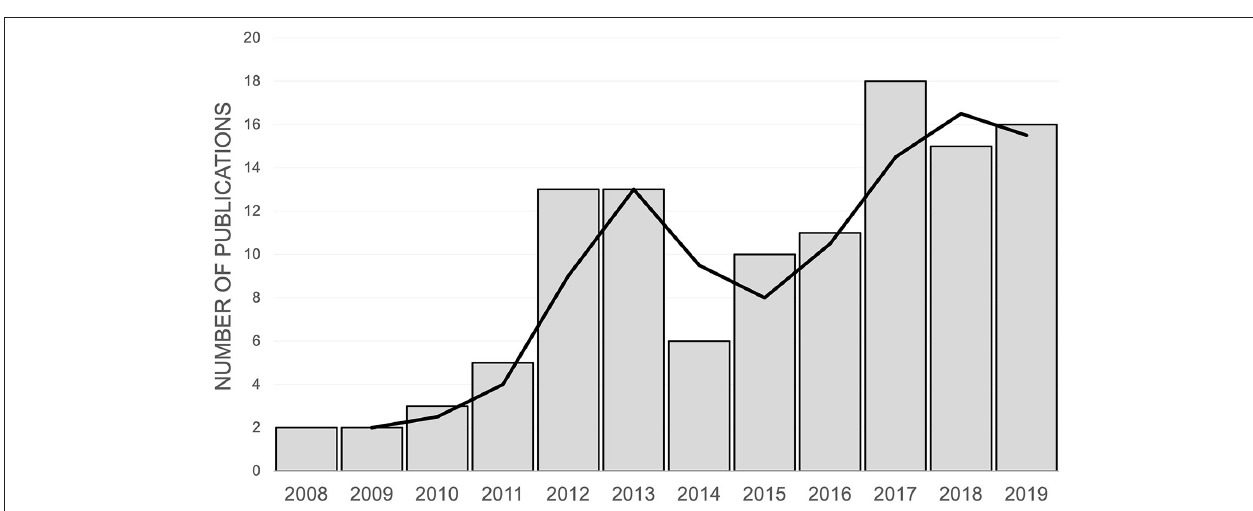
FIGURE 2 | The number of publications using the CMPS-SF by year of publication between 2007 and 2019. The trendline represents a 2-year rolling average of the number of publications.